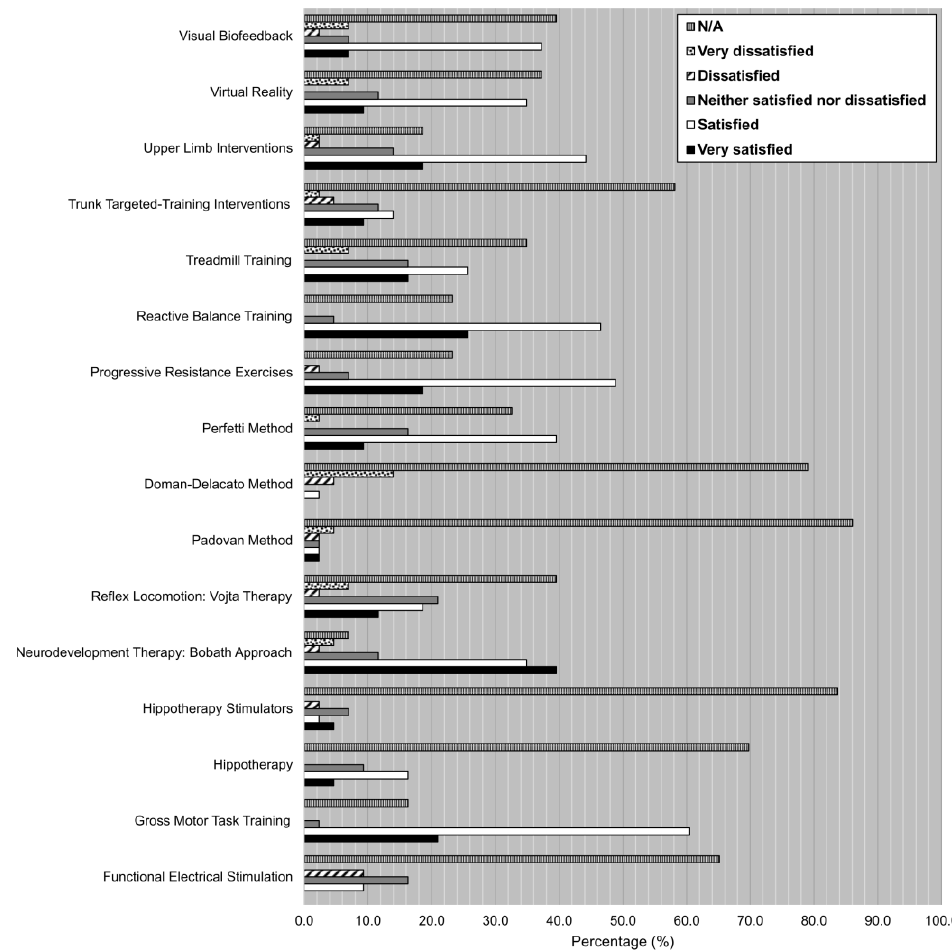
Figure 4. Degree of satisfaction (%) for each one of the techniques, therapies and interventions listed on the survey. Scale: very satisfied, satisfied, neither satisfied nor dissatisfied, dissatisfied, very dissatisfied, N/A.